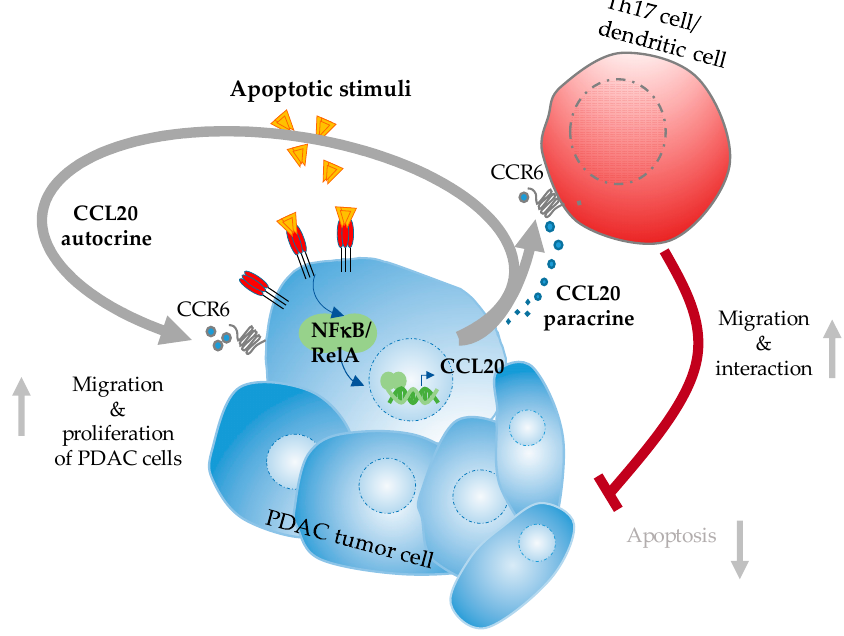
Figure 3. CCL20/CCR6 auto-and paracrine interactions in PDAC. Illustration of the interactions of the tumor cells with immune cells (right part of Figure 3) and the autocrine loop mediated by NF- κ B controlled CCL20 release of the tumor cells.